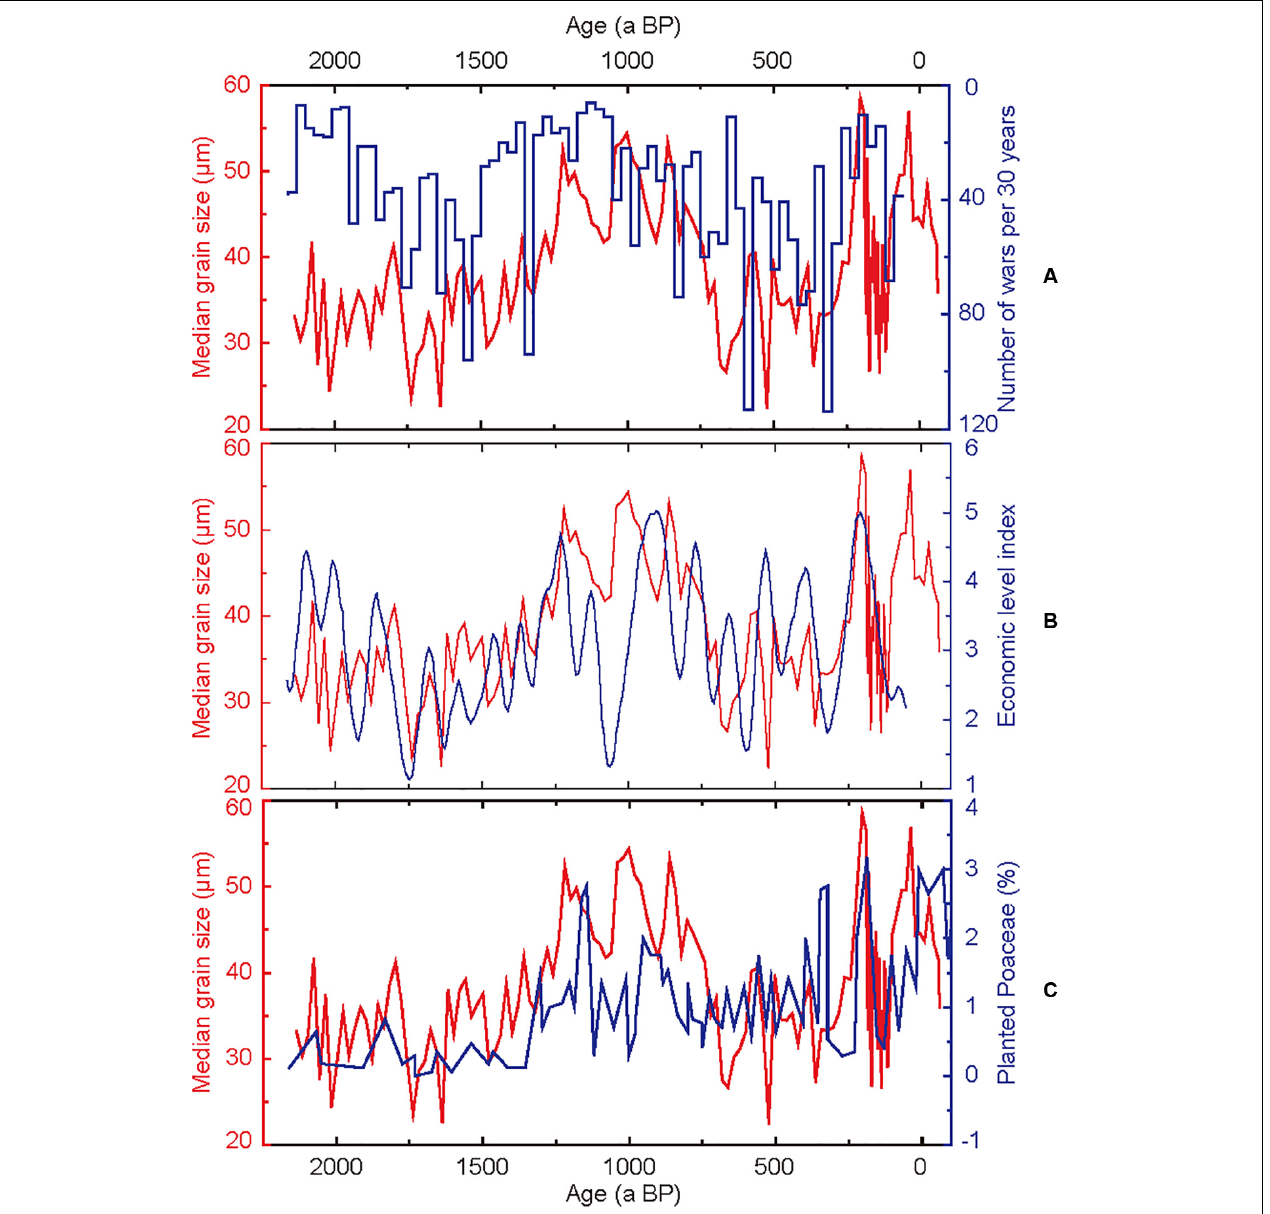
FIGURE 6 | Comparison of median grain size in sediments from Core 38002-A and records of (A) war frequency (Ge et al., 2014), (B) economic index (Wei et al., 2015), and (C) pollen percentages of planted Poaceae from Lake Gonghai (Xu et al., 2017).